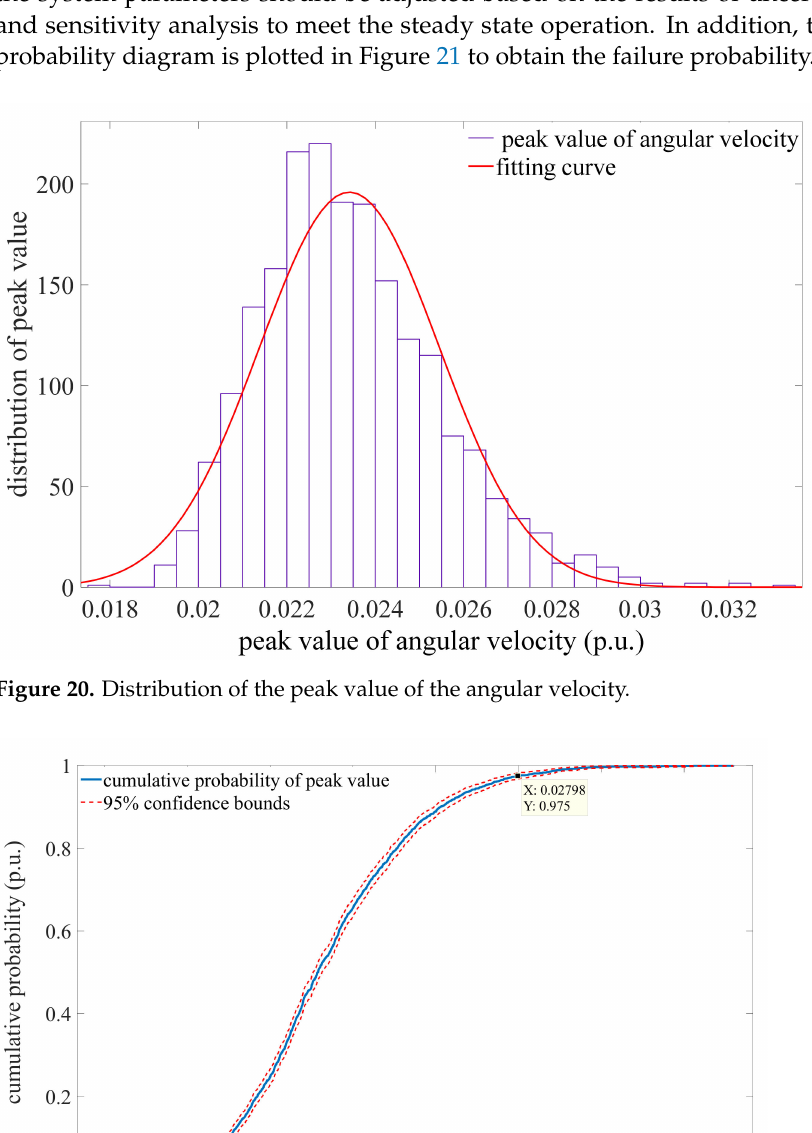
velocity. The blue solid line is the cumulative probability curve for the peak value, and the red dashed line is the 95% confidence bounds. From Figure 21, it can be seen that the blue solid line is within the 95% confidence bounds, meaning that the simulation